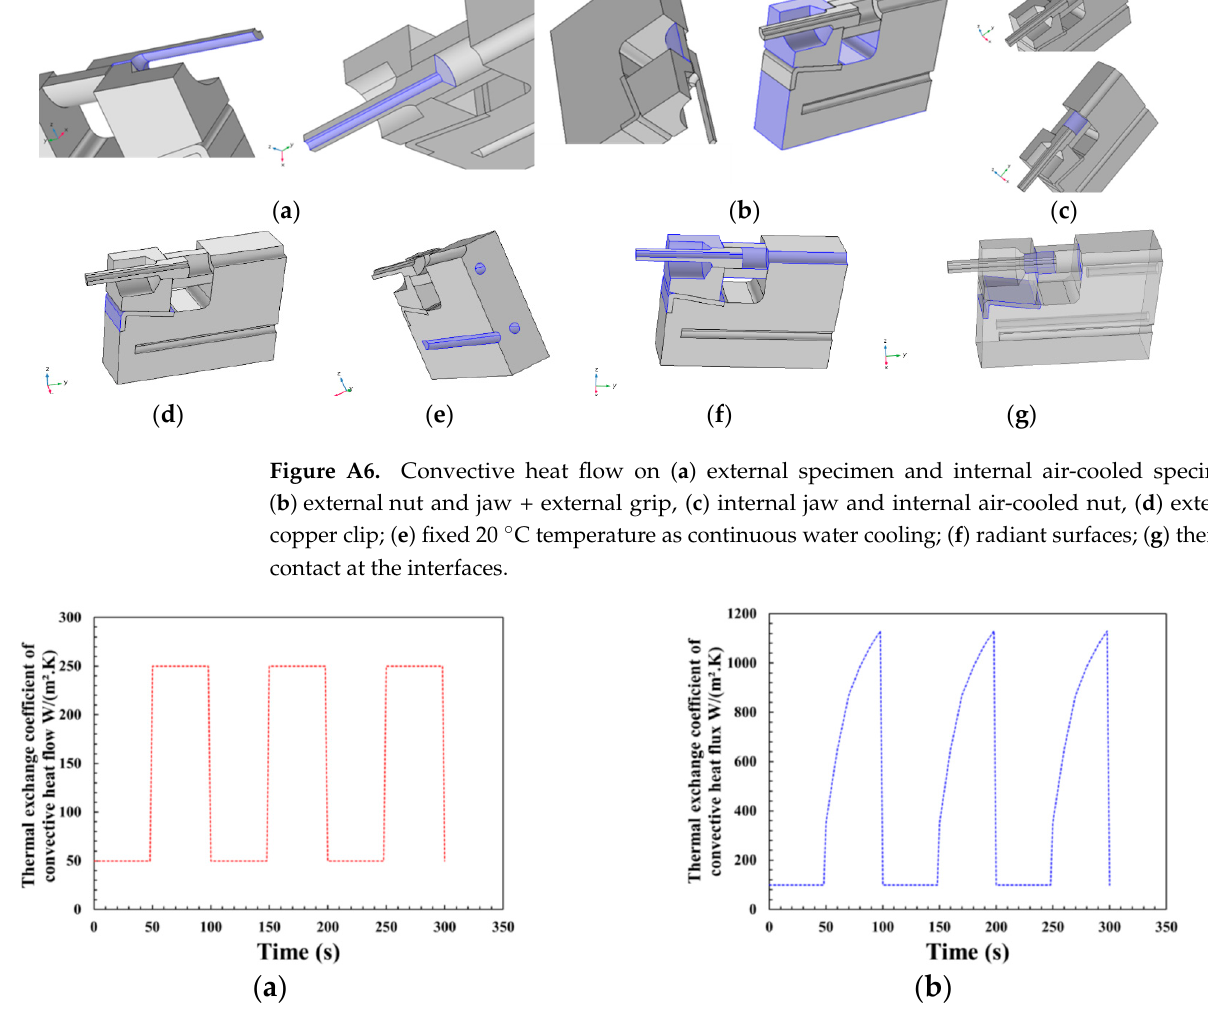
Figure A7. Evolution of thermal exchange coefficients of convective heat flow ( a ) nut and inner jaws, and ( b ) inner specimen during successive heating and cooling phases of TMF cycles.